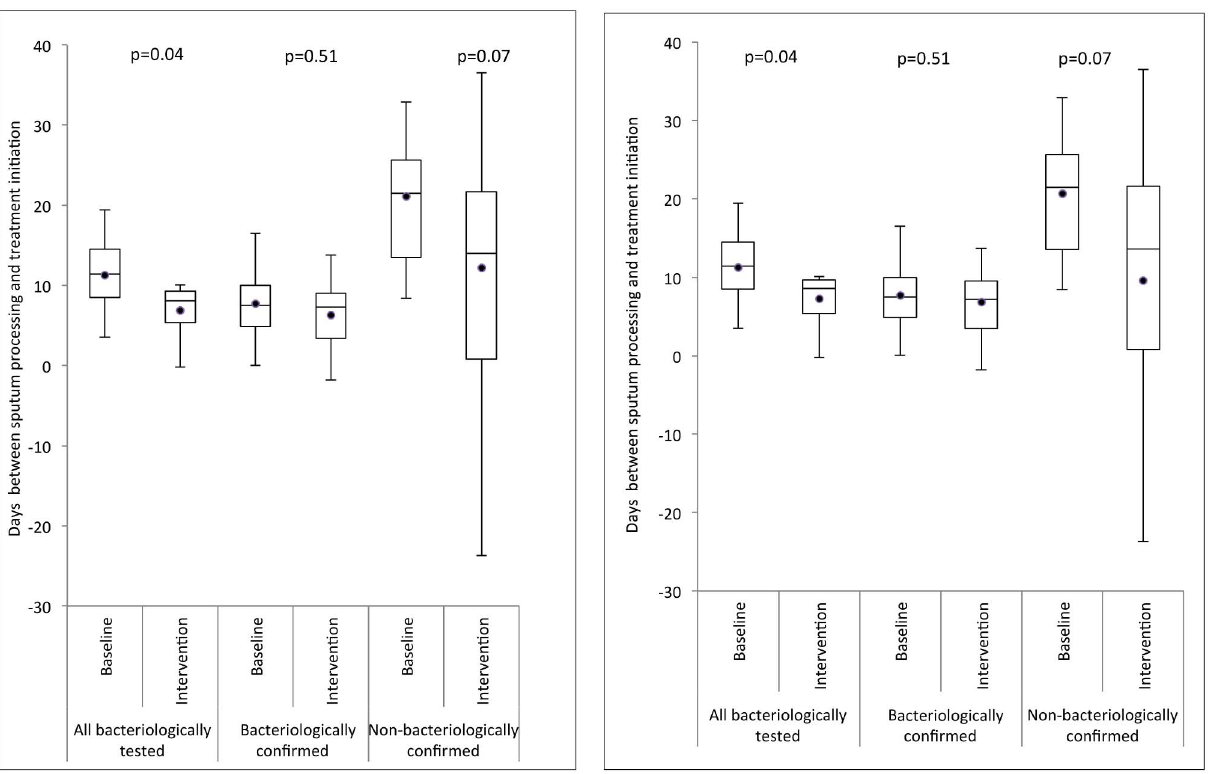
Figure 4. Box-and-whisker plot of cluster-averaged time interval between processing of sputum and start of first-line drug treatment in the baseline (smear examination) and intervention (Xpert MTB/RIF) arms. Delays are shown for three groups: (1) all TB patients notified for whom a sputum test was performed, (2) TB patients notified with bacteriological confirmation, and (3) TB patients notified without bacteriological confirmation. Left: per-protocol analysis; right: ITT